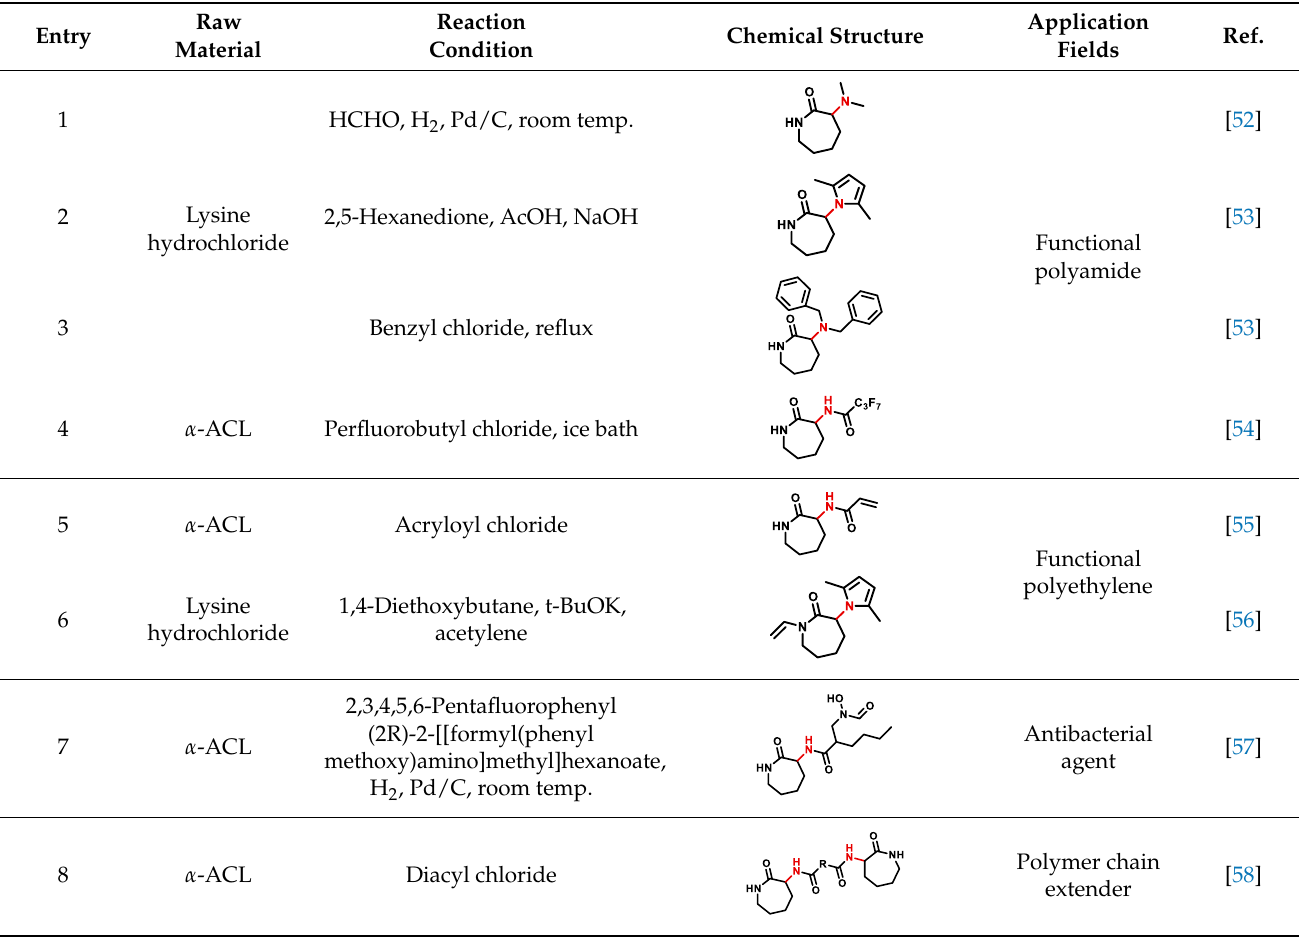
Table 1. Derivation and utilization of α -ACL.